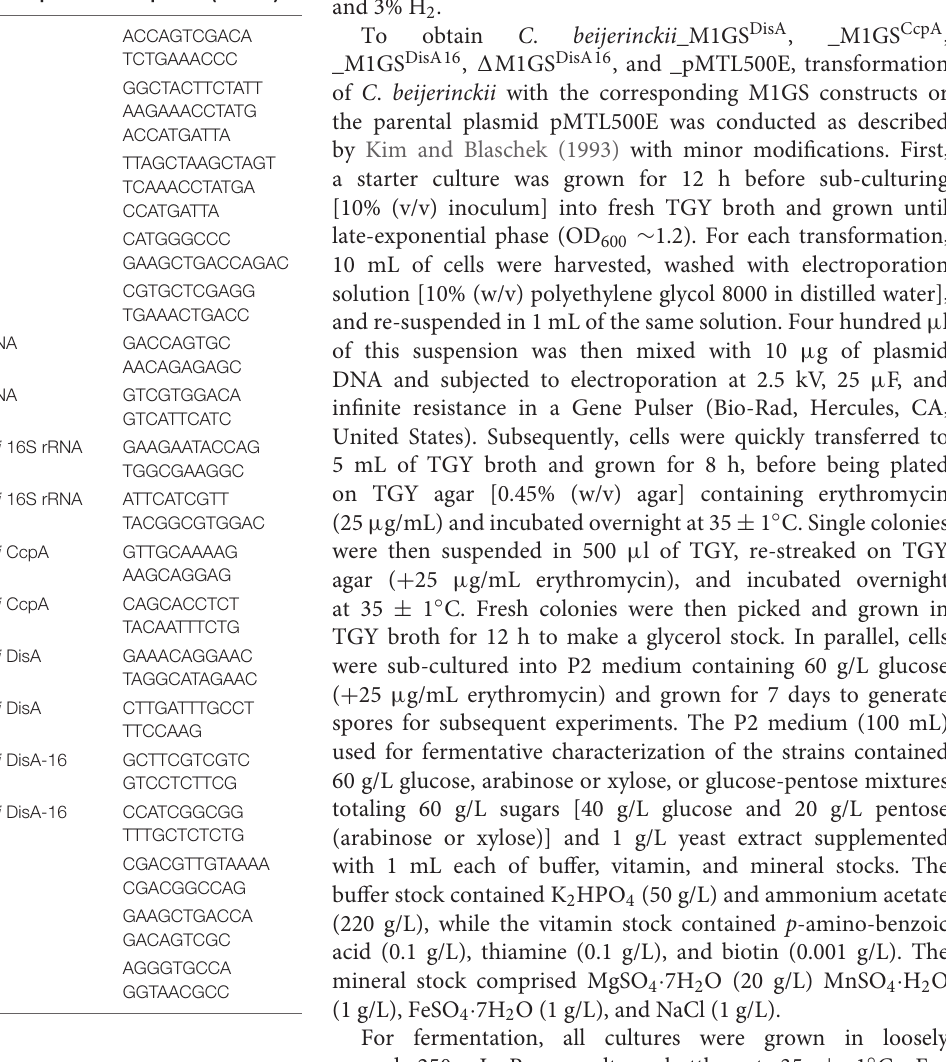
M1GS DisA16 that targets 16 nucleotides (334-349) in DisA ORF ( Figure 1D ). For use as a negative control, we generated (cid:49) M1GS DisA16 where an M1 RNA deletion mutant ( (cid:49) M1) substituted for the wild type such a control provides an opportunity to assess gene expression changes arising solely from antisense effects (Liu and Altman, 1995; Gopalan et al., 2002). All the cloned inserts were verified by sequencing before using to transform C .